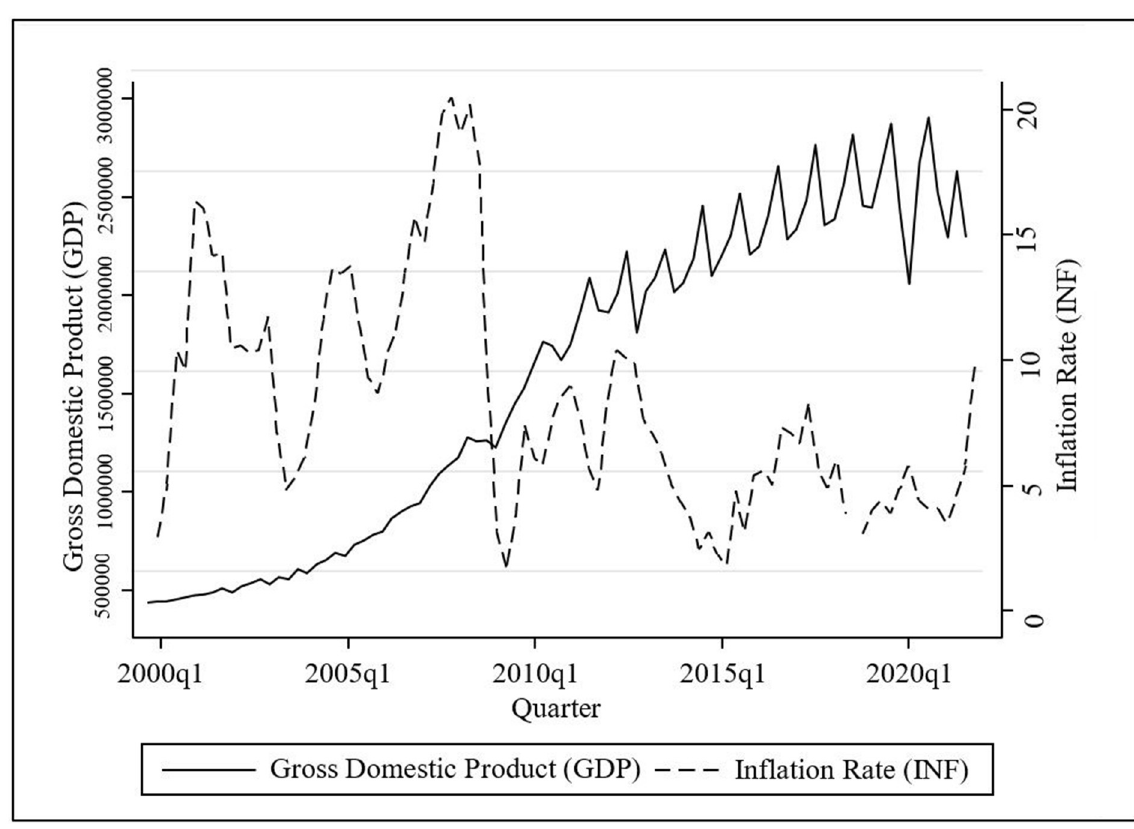
Fig 2. Graphical representation of changes between inflation and economic growth. Source: Authors’ illustration based on CBSL [56] and DCS [57].